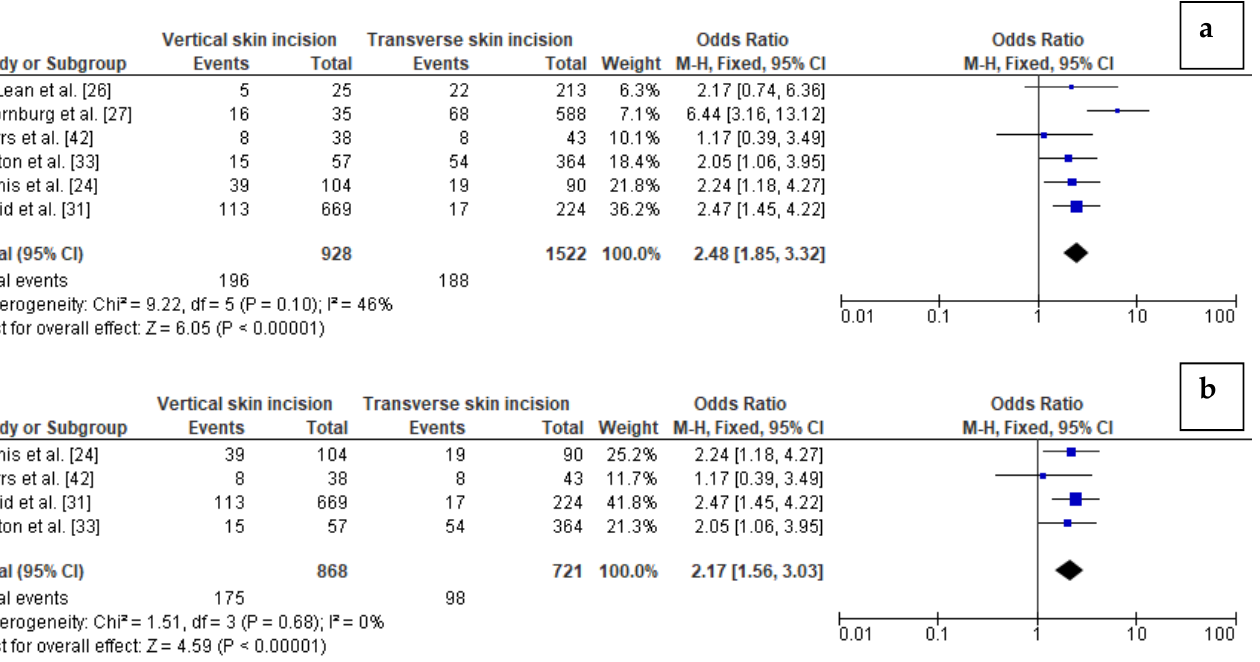
Figure 2. Forest plots for: ( a ) wound complications in the group of post-caesarean obese women with vertical skin incision and in women with transverse skin incision; ( b ) wound complications in the group of post-caesarean women with BMI ≥ 40 kg/m 2 and vertical skin incision compared to women with transverse skin incision. M.-H.—Mantel-Haenszel; CI—confidence interval; I 2 —heterogeneity; df—degrees of